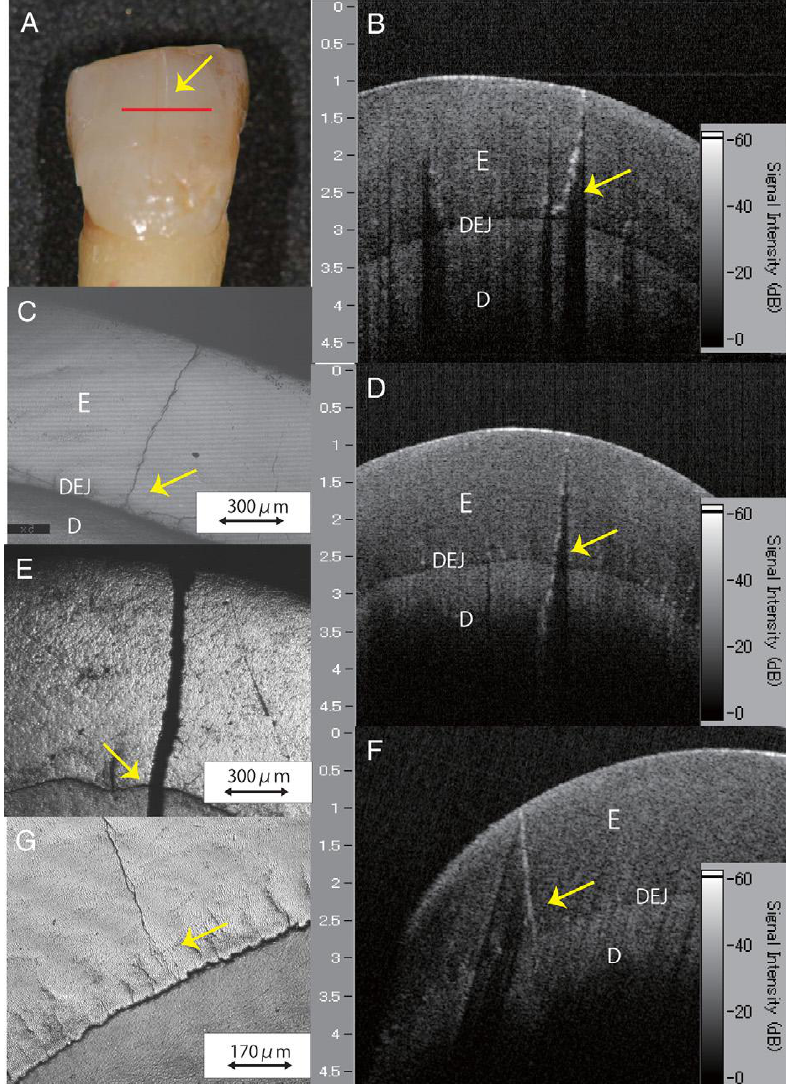
Figure 4. Images of a distinct enamel crack. ( A ) A visual examination of enamel